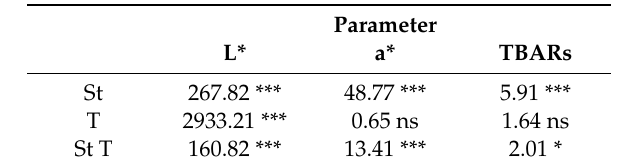
Figure 1. Colorimetric parameters of luminosity (L*) ( A ) and red index (a*) ( B ) of mechanically separated mantis shrimp flesh during frozen storage at − 10, − 18 and − 26 °C. Different letters indicate significant differences (at p < 0.05) among samples. Table 2. F value and relative significance of the influence of storage time (St) and temperature (T) and their interaction (St T) on color parameters (L* and a*) and lipid oxidation (TBARs) data of fresh mantis flesh obtained by manual and mechanical